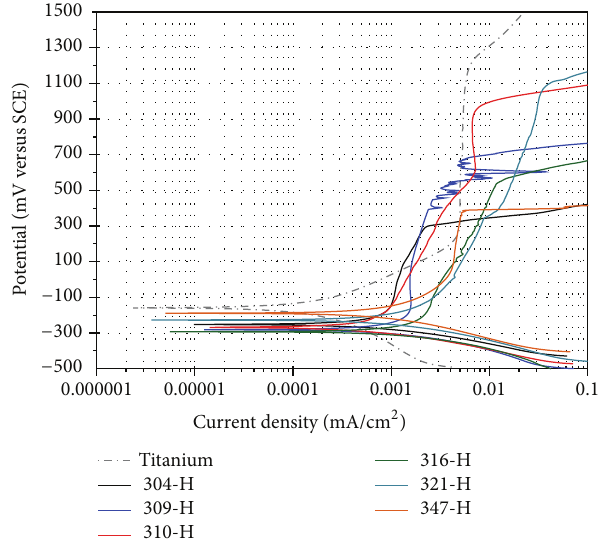
Figure 1: Polarization curves of materials in artificial saliva at 37 ∘ C, dE/dt = 1.0